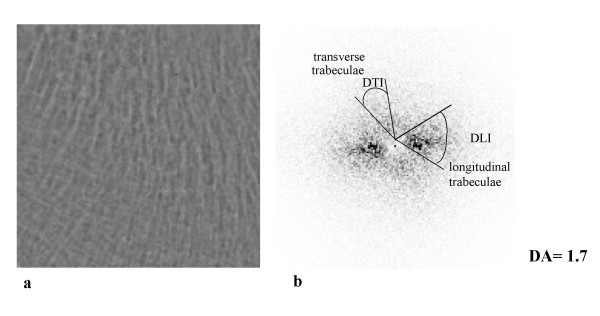
Vertebral fracture case a Region of Interest (ROI) of the digitized radiographic image of calcaneus trabecular bone. b FFT spectrum DLI : Dispersion Longitudinal Index, spreading angle of the longitudinal trabeculae DTI : Dispersion Transverse Index, spreading angle of the transverse trabeculae